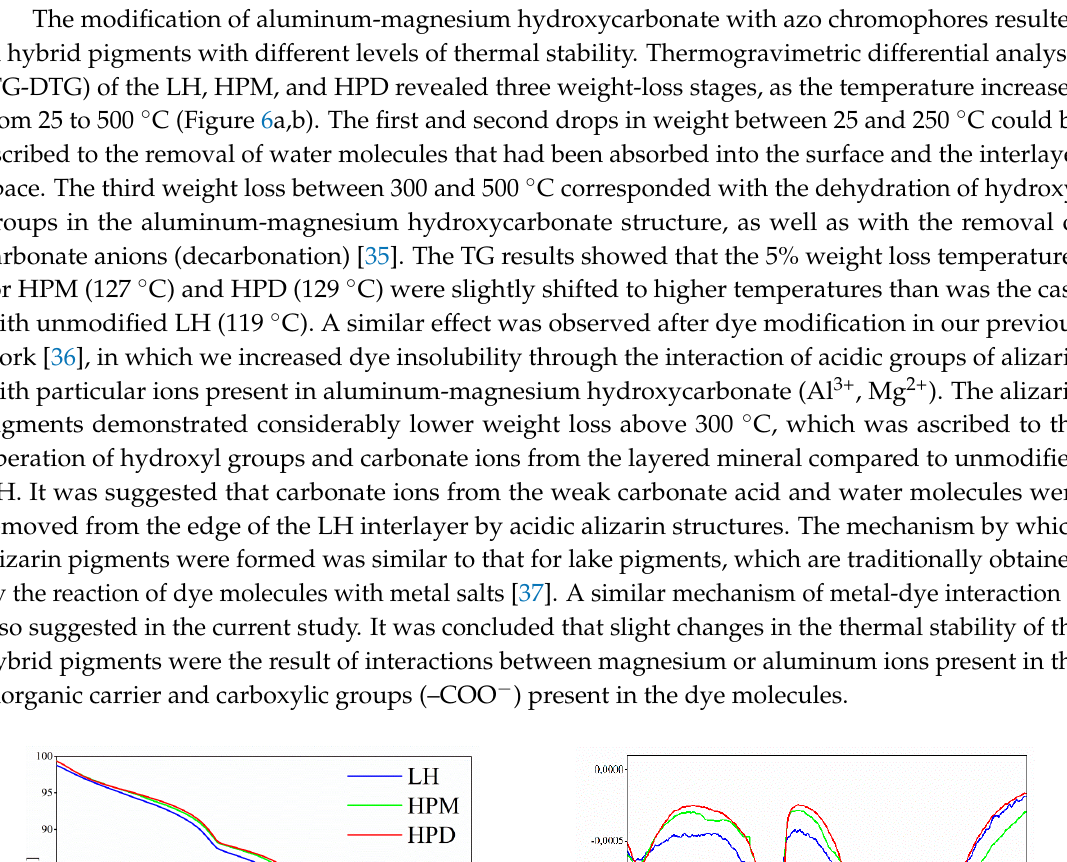
Figure 7. Digital photos of azo dye and hybrid pigment powders immersed in various organic solvents. 3.2. Kinetics of Curing The influence of organic-inorganic pigments on the curing behavior of NBR and EPM compounds was estimated based on rheometric measurements. Figure 8 depicts curing graphs for NBR and EPM compounds filled with 5 phr and 10 phr of hybrid pigments. As can be seen, over time the blends containing pigments exhibited an abrupt increase in torque value compared to the reference. The cure properties of the elastomer composites are also summarized in Table 4. As expected, with increasing filler content, the minimum and maximum of the torque moment increased